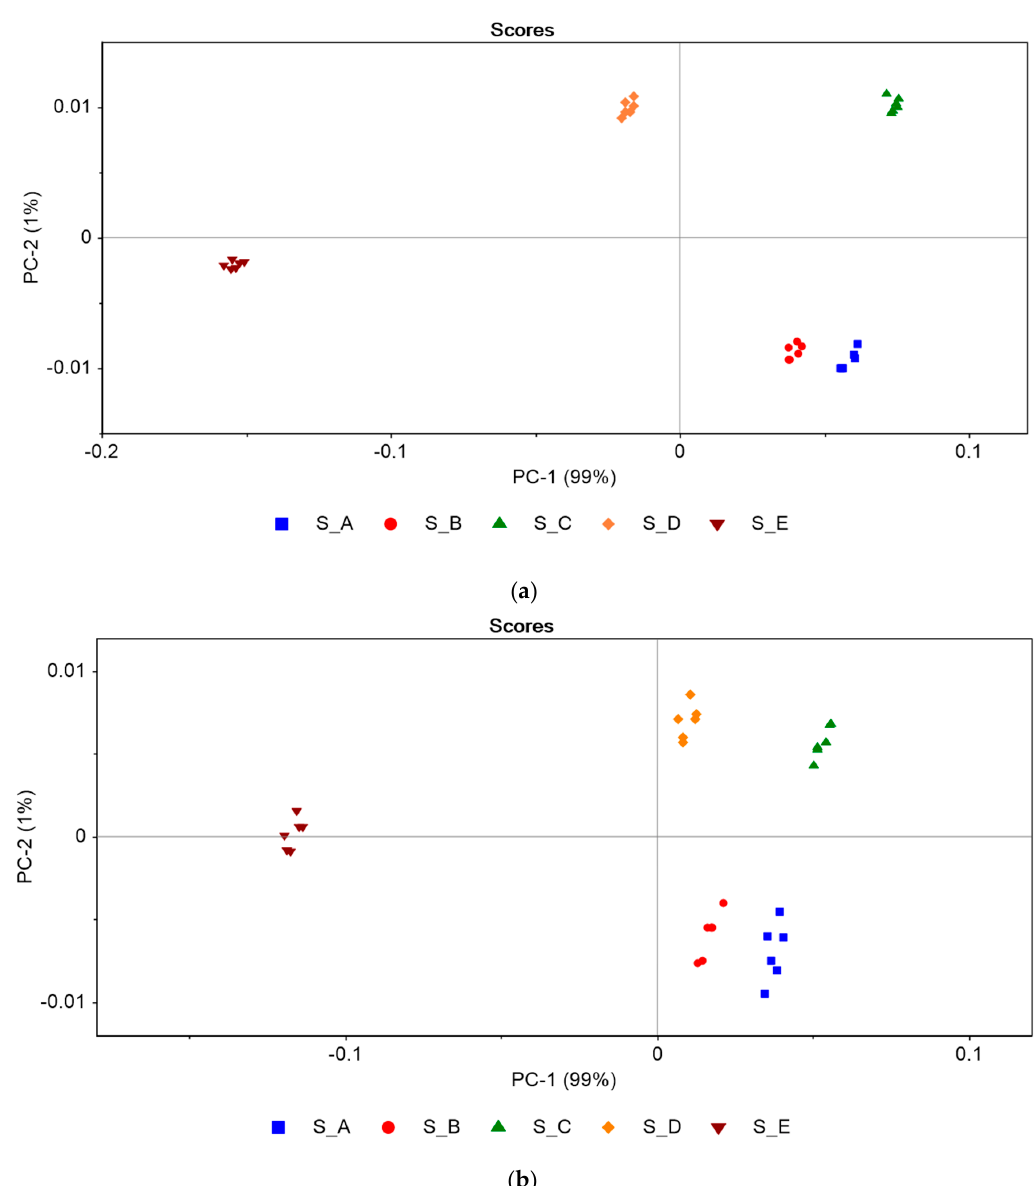
Figure 5. Scattering plot of the component score values for the PCA method of samples of effervescent tablets S_A–S_E dissolved ( a ) in acetate buffer and ( b ) in distilled water. Each sample was measured 6 times and each point on the graph corresponds to the average value of 3 measurements.